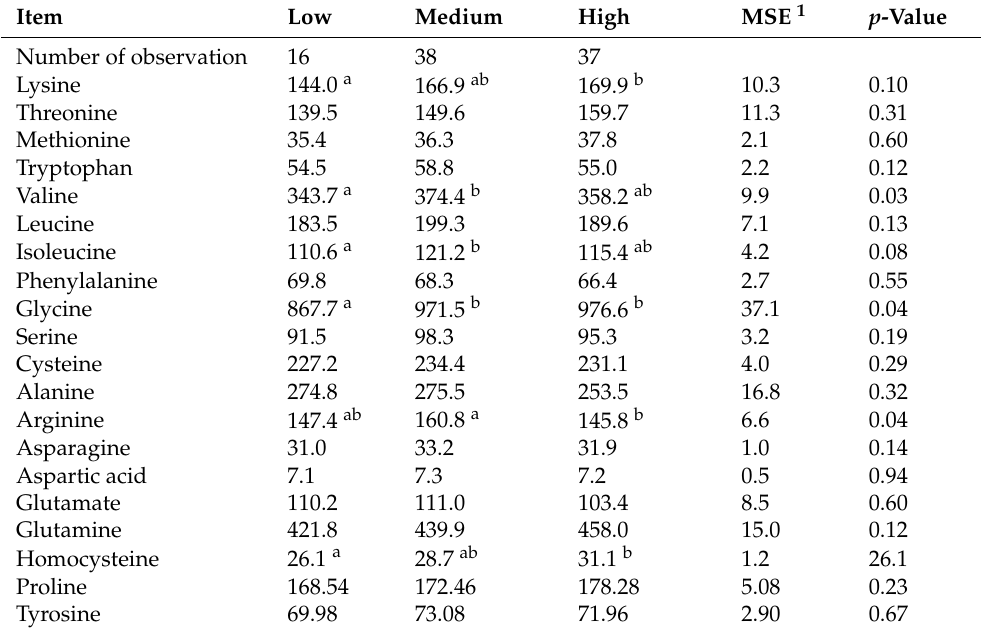
Table 4. Final plasma amino acid concentration ( µ mol) in growing barrows (35–60 kg body weight) fed daily tailored diets varying lysine (Lys) and threonine (Thr) levels and clustered in low (167 g/d), medium (191 g/d), and high (213 g/d) protein deposition